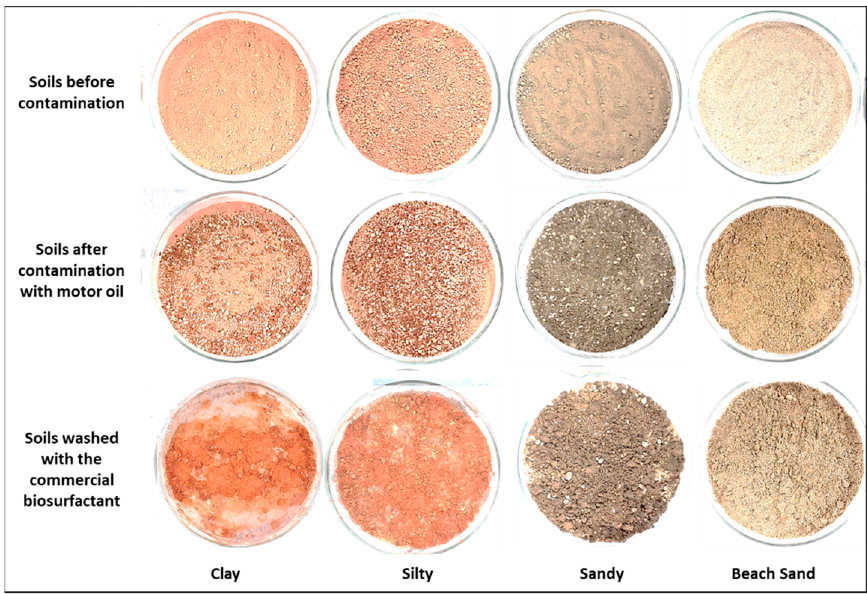
Figure 10. Illustration showing appearance of the soil samples before contamination, after contam- ination with motor oil, and washed with the formulated biosurfactant applied in kinetic assay.